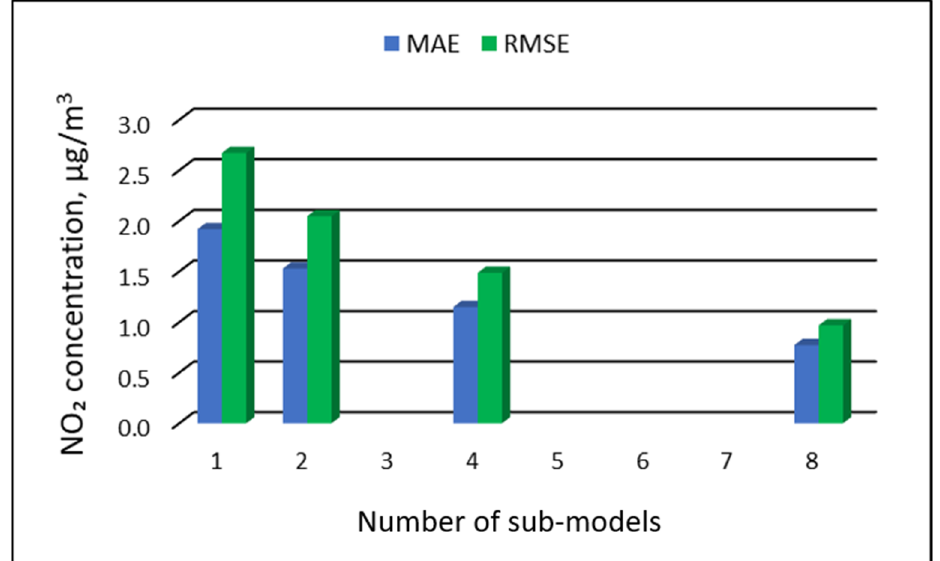
Figure 16. Overall MAE and RMSE values for NO 2 concentration prediction in RVS models depend- ing on the number of created sub-models, Z ł oty Potok.